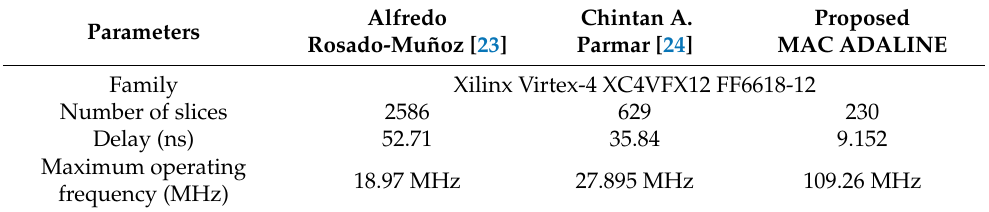
Table 5. Synthesis comparison of proposed MAC LMS filter with adaptive architectures.